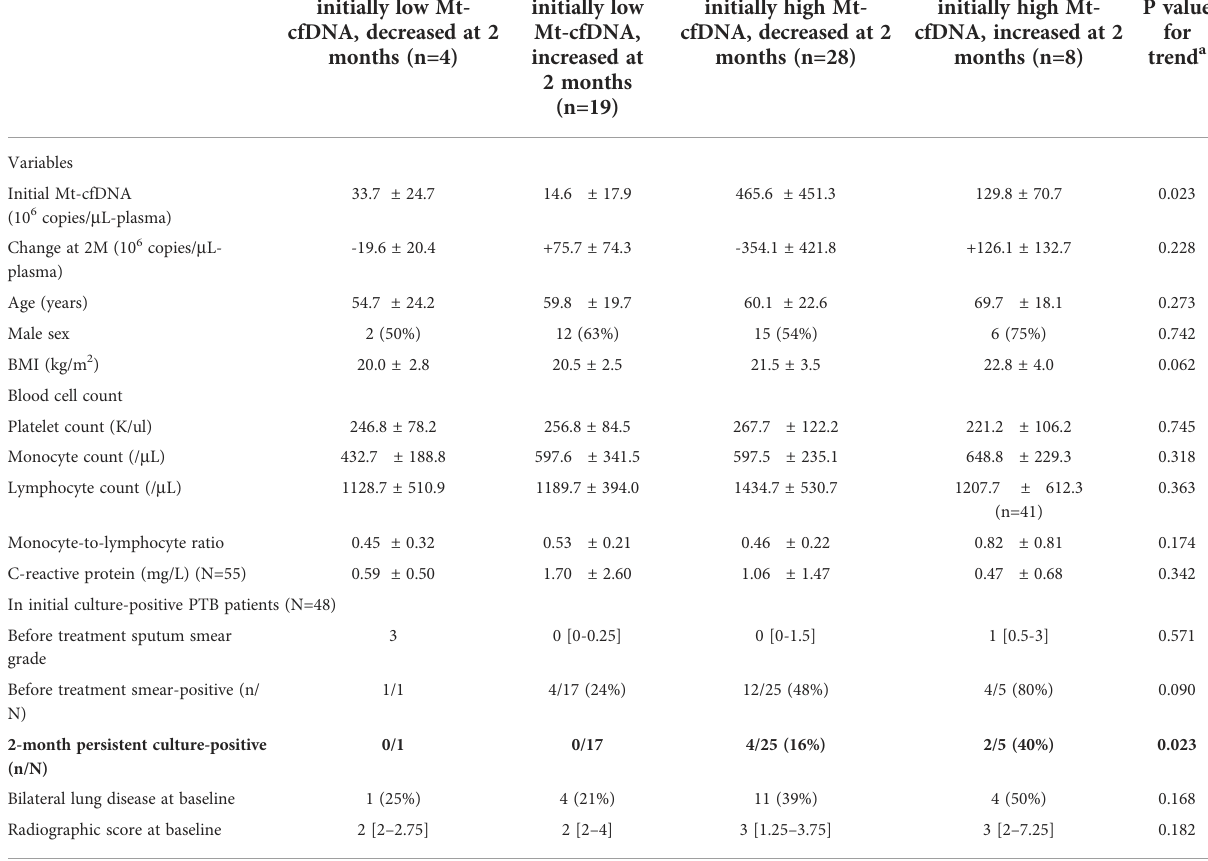
TABLE 4 Characteristics of pulmonary tuberculosis (PTB) patients strati fi ed by Mt-cfDNA dynamic change at 2 months of treatment (N=59).